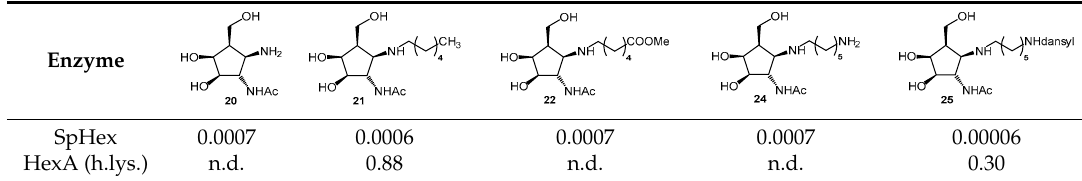
Table 1. Inhibitory activities of new compounds with N -acetylhexosaminidases.